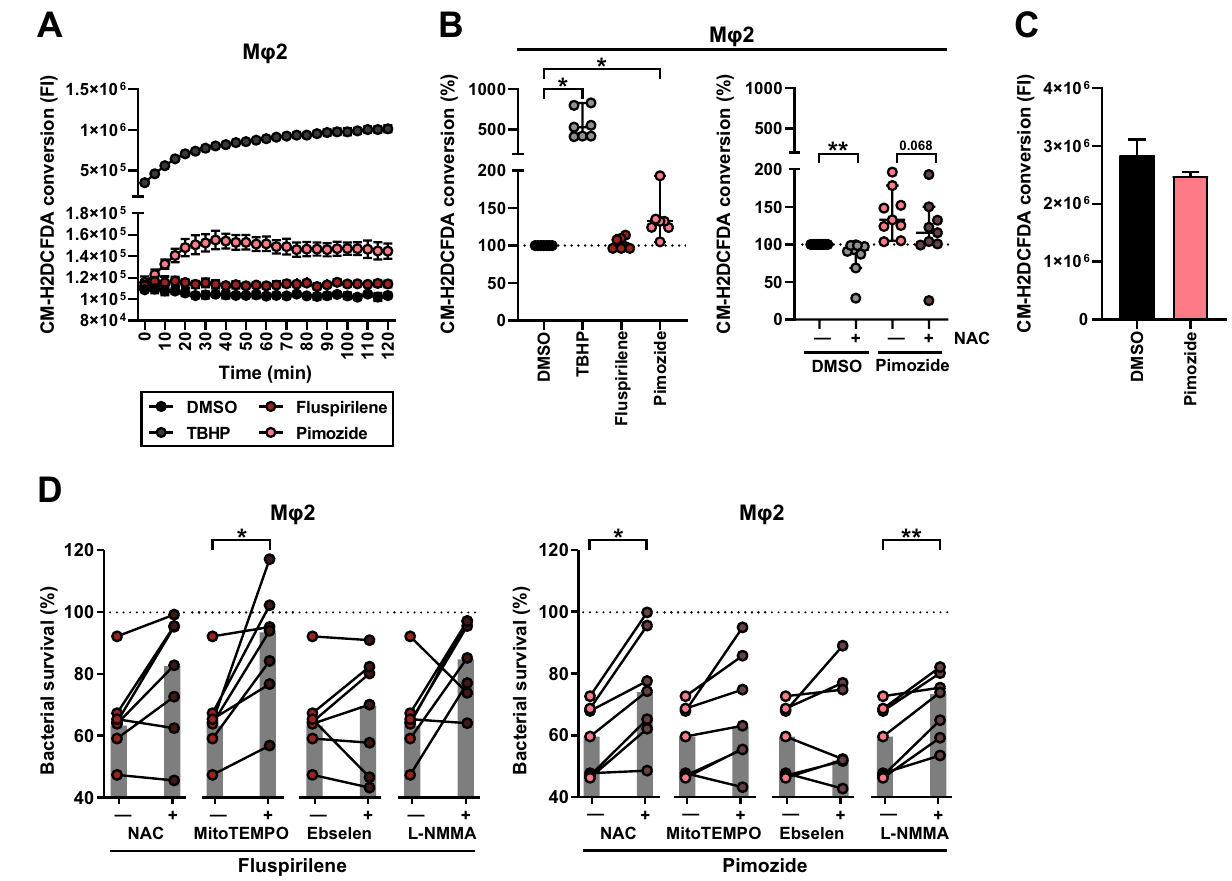
Figure 5. Pimozide induces ROS/RNS production and antioxidants impair bacterial killing by Pimozide as well as Fluspirilene. ( A ) Mφ2 were pulsed for 30 min with 5 µM of probe CM-H2DCFDA followed by exposure to 10 µM Fluspirilene or Pimozide, 50 µM TBHP as positive control, or DMSO at equal v/v. Production of reactive oxygen species (ROS) was monitored by measuring Fluorescence intensity (522 nm) over a time course of two hours. Each dot depicts the mean of 3 replicates of a representative donor (7 donors in total). ( B ) Mφ2 were pulsed for 30 min with 5 µM of probe CM-H2DCFDA followed by exposure to 10 µM Fluspirilene or Pimozide, 50 µM TBHP as positive control or DMSO at equal v/v for the duration of the experiment (left panel). Pimozide and DMSO were additionally combined with 5 mM of the antioxidant N-acetyl cysteine (NAC) (right panel). Each dot represents the area under the curve (AUC) of a single donor (7 donors in left panel and 9 donors in right panel) and depicts the mean of 3 to 6 replicates. Median with 95% confidence intervals are shown. Statistical significance was tested using a Wilcoxon matched-pairs signed rank test with post-hoc Benjamini– Hochberg correction (left panel) (* = q-value < 0.1) or Wilcoxon matched-pairs signed rank test (right panel) (** = p -value < 0.01). ( C ) Probe CM-H2DCFDA (5 µM) fluorescence measured in the presence of 10 µM of Pimozide or DMSO at equal v/v in the absence of cells. Bars display the mean ± standard deviation of 3 replicates and represent the fluorescence intensity measured after 60 min of incubation in one single experiment. Statistical significance was tested using an unpaired t test with Welch’s correction. ( D ) CFU assay of Mtb - infected Mφ2 and treated with 10 µM of Fluspirilene (left panel) or Pimozide (right panel) combined with anti- oxidants (5 mM of NAC, 10 µM of MitoTempo, 25 µM of Ebselen or 1 mM of L-NMMA) or DMSO at equal v/v for 24 h. Each dot represents a single donor (7 donors in total) and depicts the mean of 3 to 6 replicates. Dotted lines indicate DMSO set at 100% with median indicated by gray bars. Statistical significance was tested using a RM one-way ANOVA with Dunnett’s multiple comparison test (* = p -value <